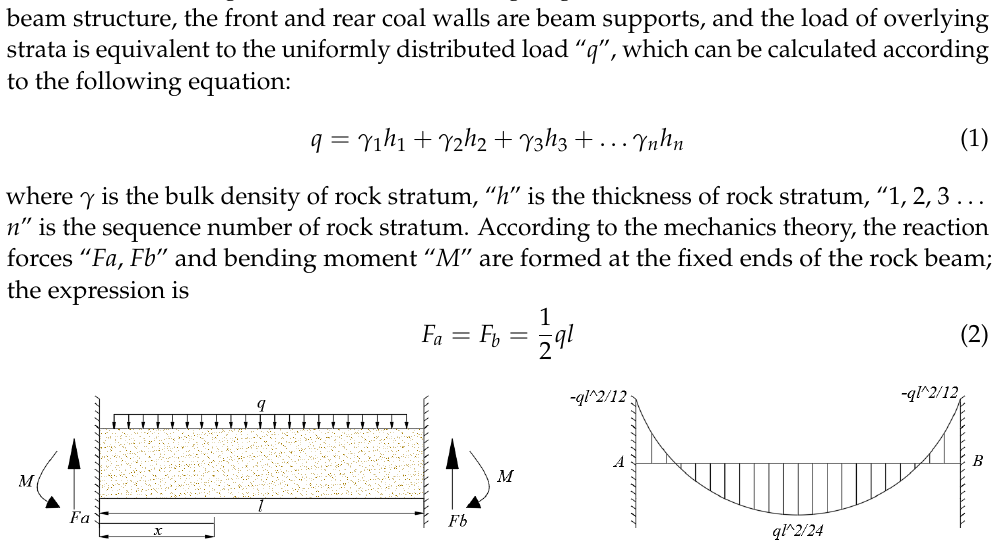
Figure 2. Mechanical model of roof fixed beam in initial mining